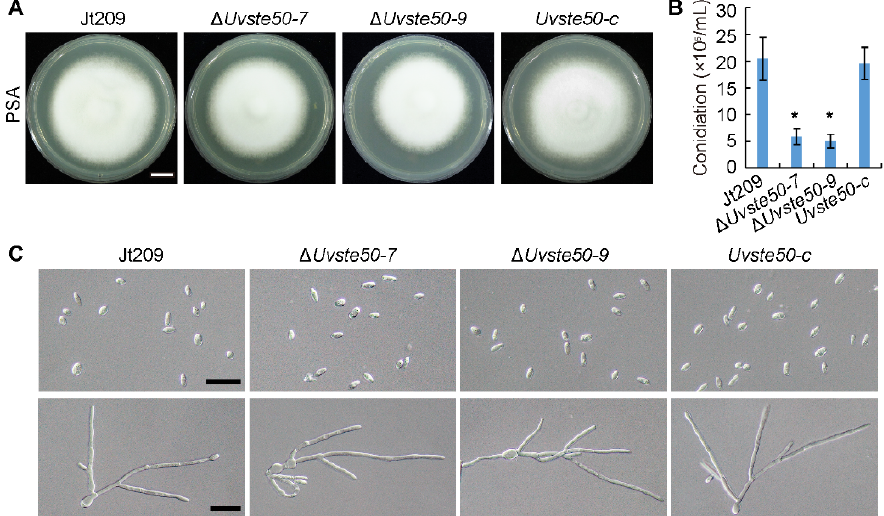
Figure 2. UvSTE50 affects conidiation in U. virens . ( A ) Colony morphology of the wild-type strain Jt209, the ∆ Uvste50 mutant, and the complemented strain Uvste50-c . All of the tested strains were incubated on PSA plates for 20 days. Bar, 5 mm. ( B ) Conidial production of Jt209, ∆ Uvste50 and Uvste50-c in liquid PSB, incubated for 6 days at 28 ◦ C, and 150 rpm. Error bars represent SD. * indicates significant differences between ∆ Uvste50 and the wild-type/complemented strains, as estimated by Duncan’s new multiple range test ( p < 0.05). ( C ) Conidial morphology and conidia germination of strains Jt209, ∆ Uvste50 , and Uvste50-c . Conidia were harvested from 6-day-old liquid PSB cultures, and conidial germination was observed 20 h post ‐ incubation. Bar, 20 μ m.